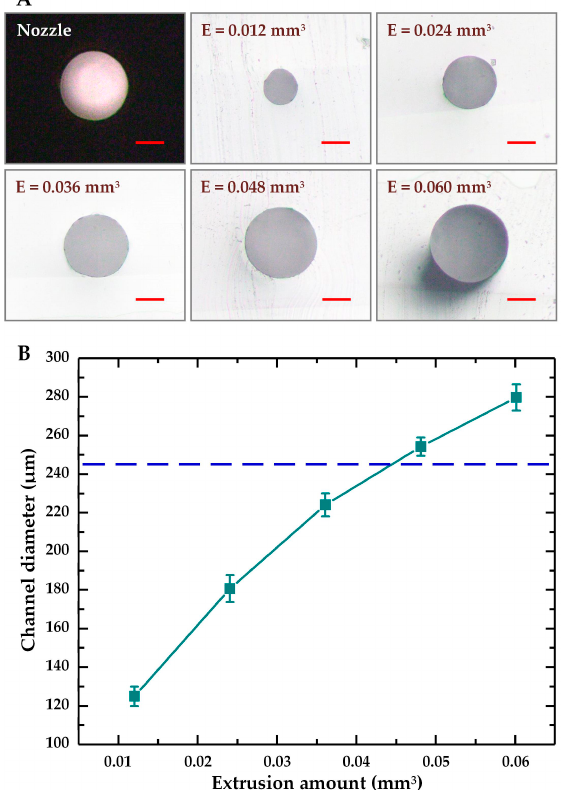
Figure 2. Fabrication of circular straight microchannel with di ff erent sizes at low extrusion amounts. ( A ) Cross-sectional images of the nozzle orifice and the microchannels fabricated at di ff erent extrusion amounts. The red scale bar is 100 µ m; ( B ) Calculated channel diameters at di ff erent extrusion amounts. The dotted line indicates the diameter of the nozzle orifice. The error bars represent the standard deviations of diameter di ff erences from ten microchannels. Micromachines 2019 , 10 , x